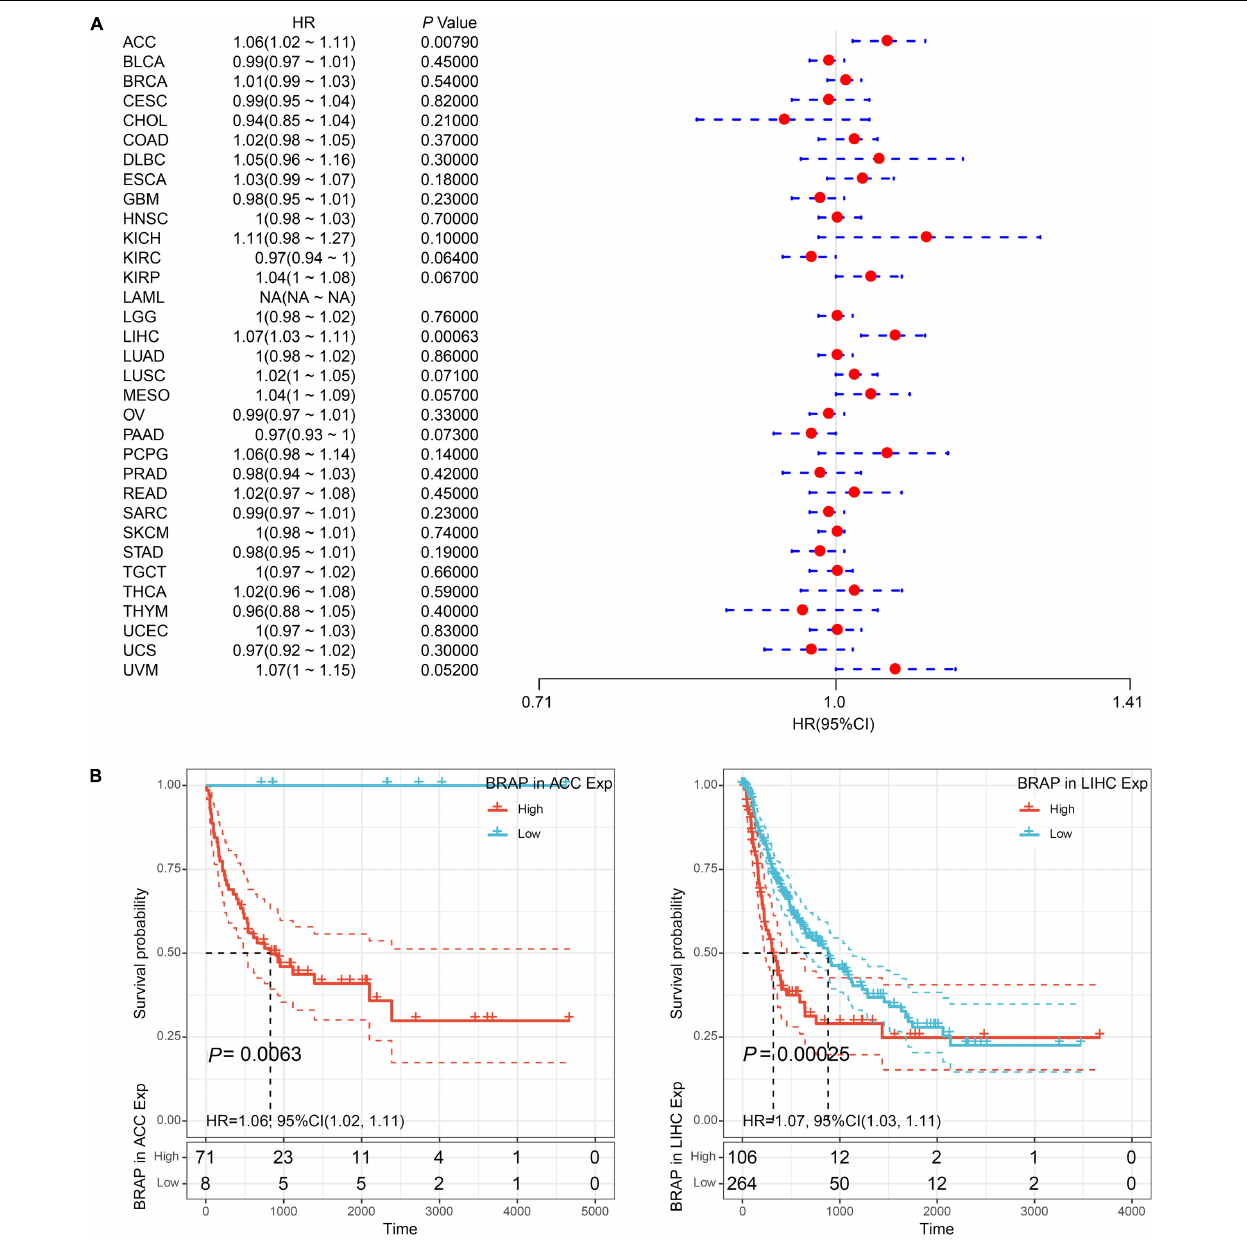
FIGURE 5 | Relationship of BRAP expression with patients’ PFI. (A) Forest plots of hazard ratios of BRAP in 33 cancer types. (B) Kaplan–Meier PFI curves for patients stratified by different expression levels of BRAP in ACC and